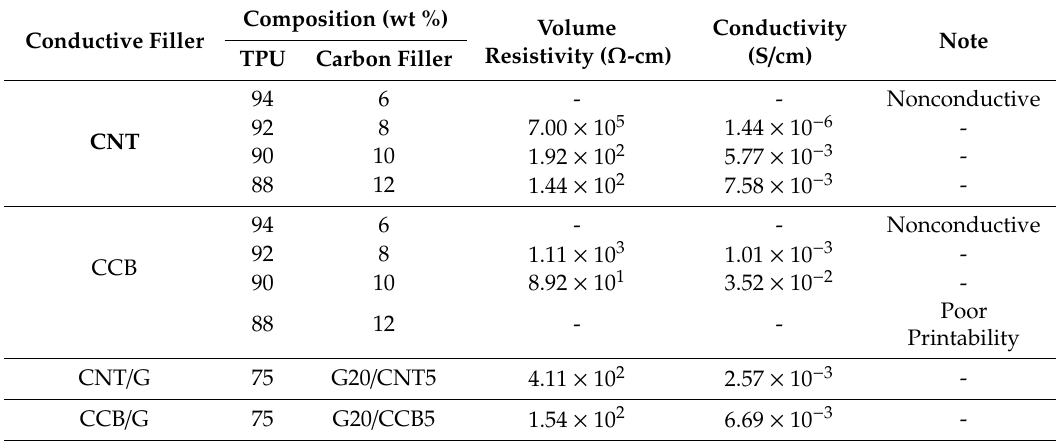
Table 2. Volume resistivity and conductivity of TPU / CNT and TPU / CCB composites. Composition (wt %) Conductive Filler